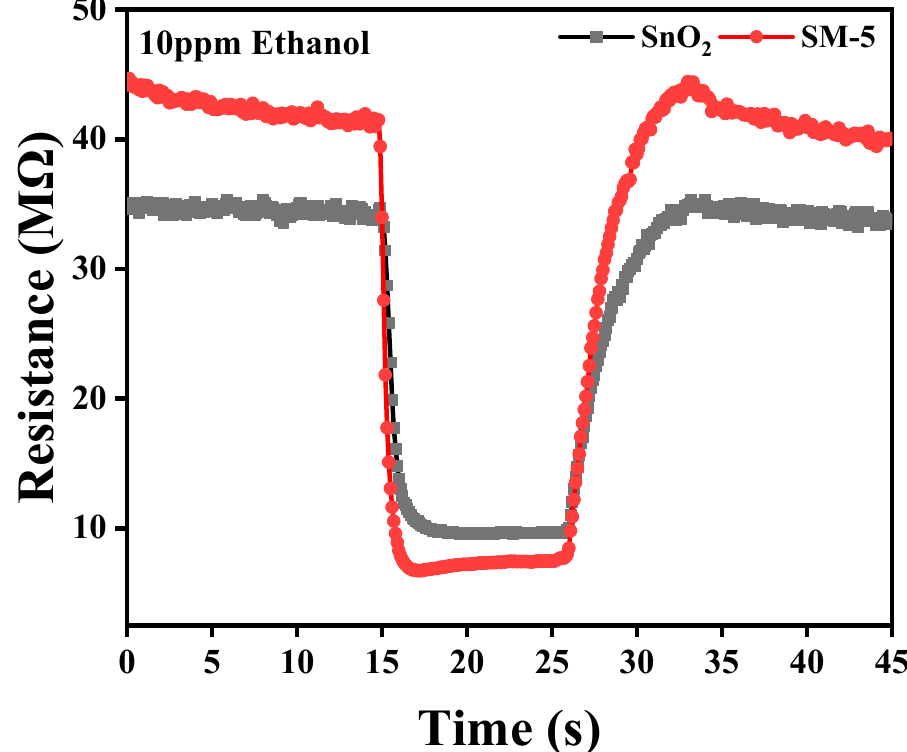
Figure 11. Schematic diagram of the sensitivity mechanism of the SnO 2 /MXene sensor.